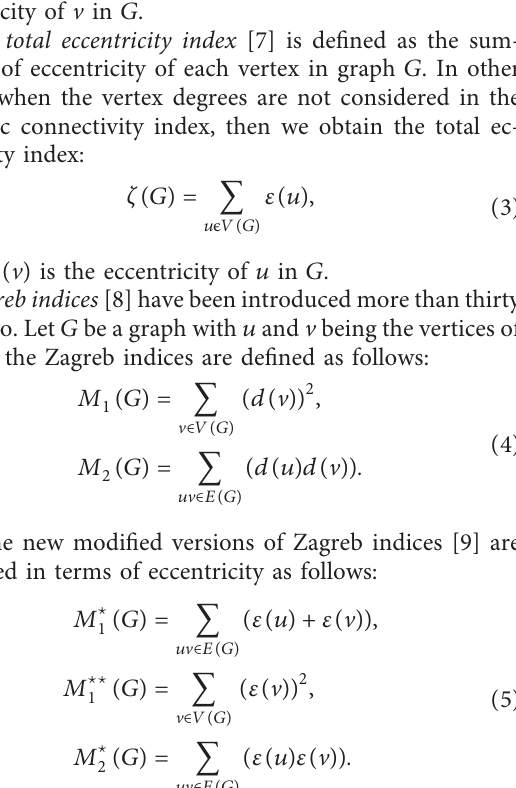
Figure 1: Binary